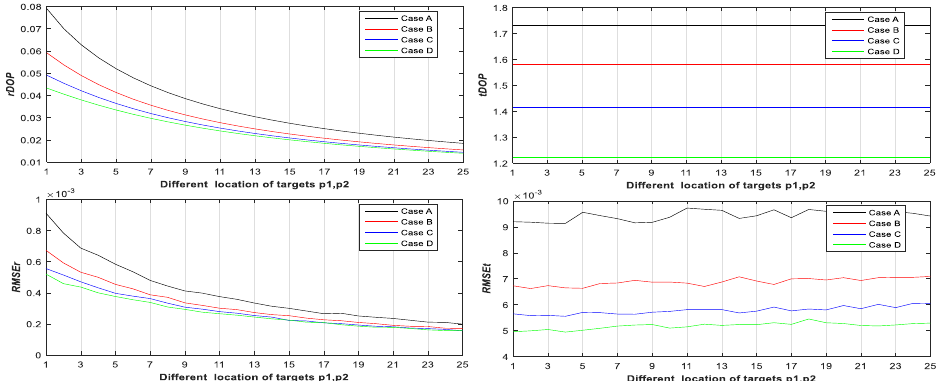
Figure 4. rDOP 2 , tDOP 2 , RMSE r ,2 , and RMSE t ,2 of Case A, B, C, and D with respect to two Figure 4. 2 rDOP , 2 tDOP , ,2 r RMSE , and ,2 t RMSE of Case A, B, C, and D with respect to two di ff erent different targets.